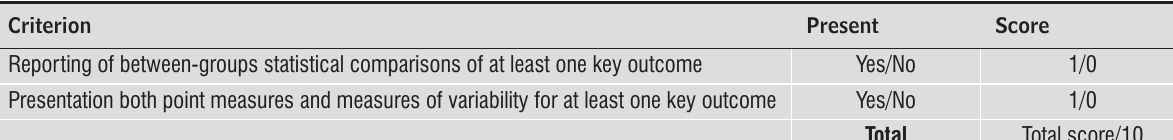
Table 1 - PEDro scale of Methodological Classification